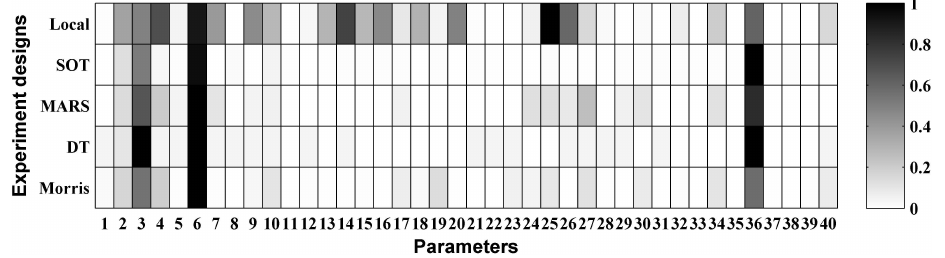
Fig. 10. The qualitative sensitivity analysis results of different methods for soil temperature. The sensitivity scores are normalized to [0, 1]; 1 means most sensitive and 0 means least sensitive.